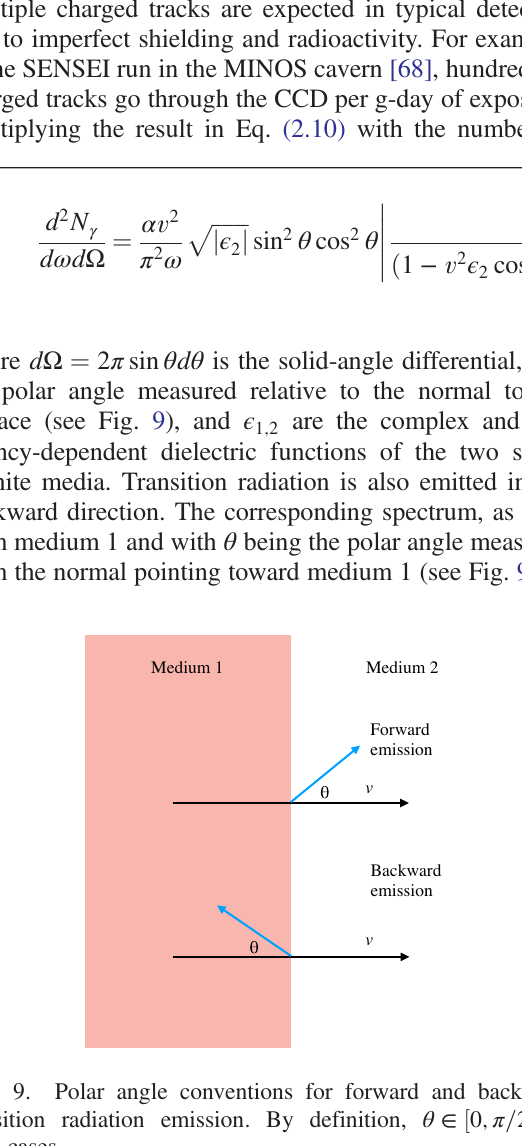
transition radiation emission. By definition, θ ∈ ½ 0 ; π = 2 (cid:2) in both